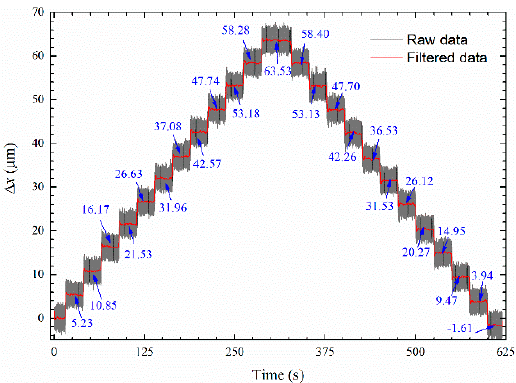
Figure 13. The dynamic response to the sequence voltage profile applied to the electrostatic comb.